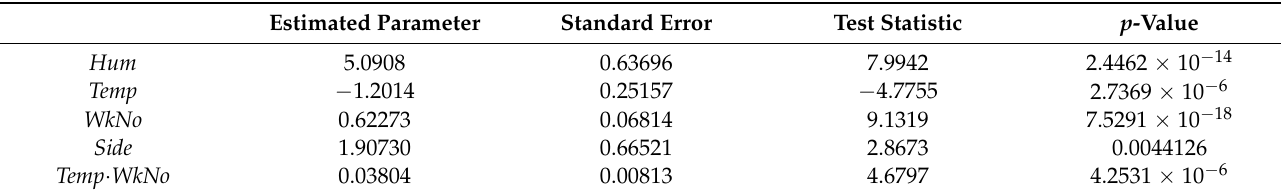
Table 3. Statistics for the multiple linear regression